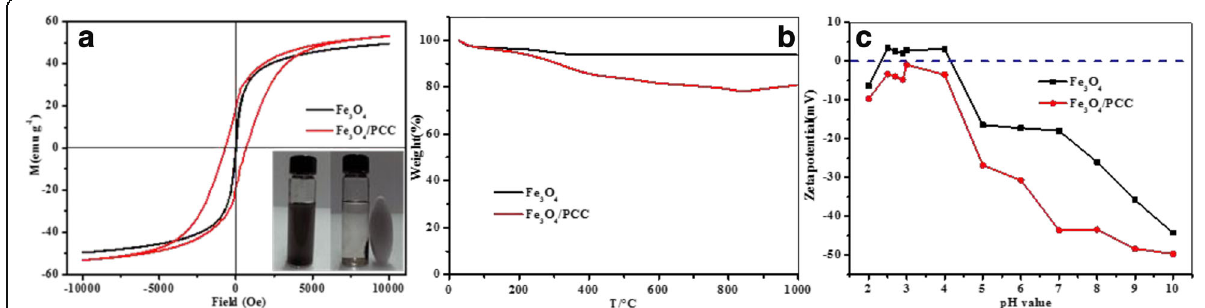
Fig. 2 a Magnetization behavior of Fe 3 O 4 MNPs and Fe 3 O 4 /PCC MNPs at room temperature. b Thermogravimetry (TGA) curves of Fe 3 O 4 MNPs and Fe